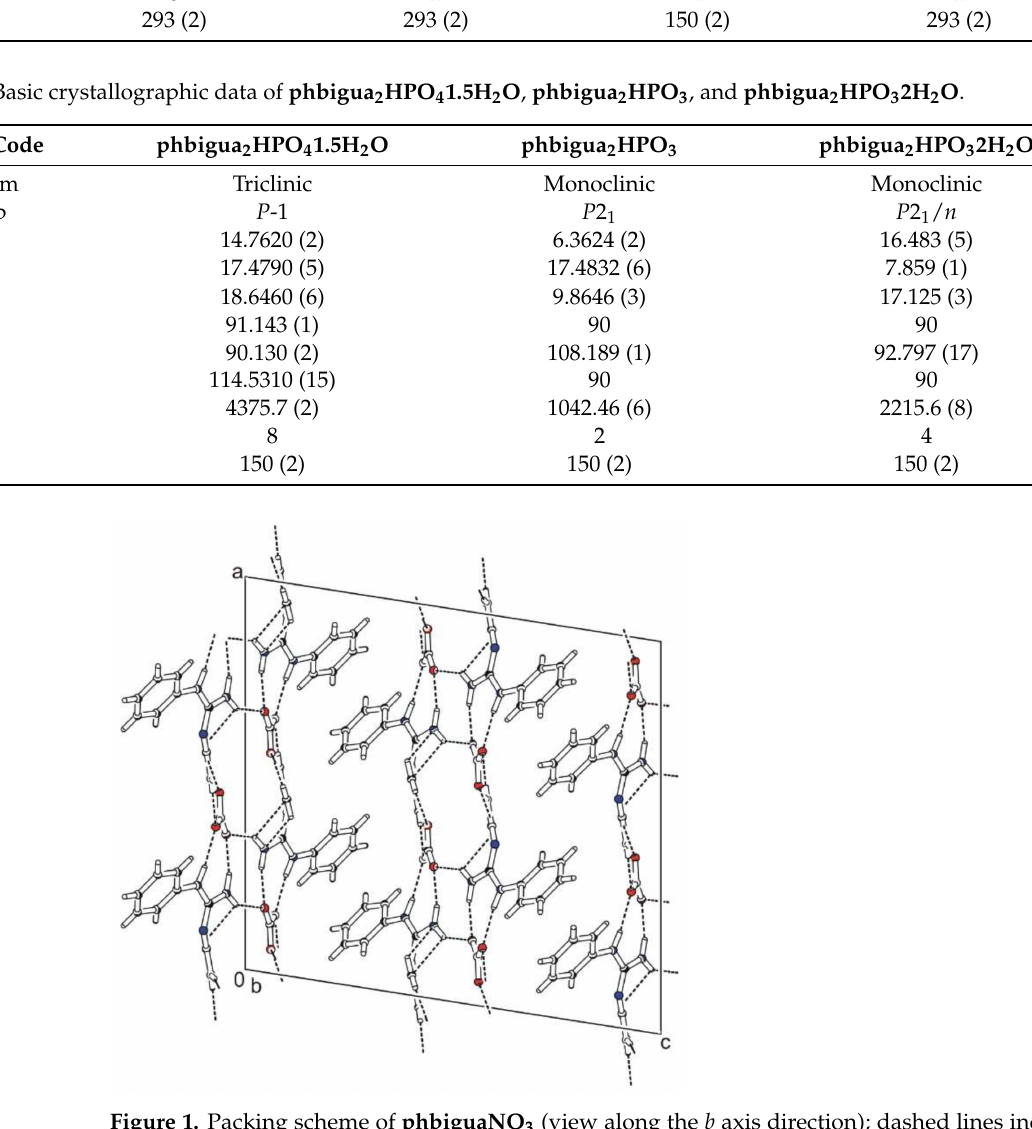
Figure 1. Packing scheme of phbiguaNO 3 (view along the b axis direction); dashed lines indicate hydrogen bonds, solid lines indicate unit